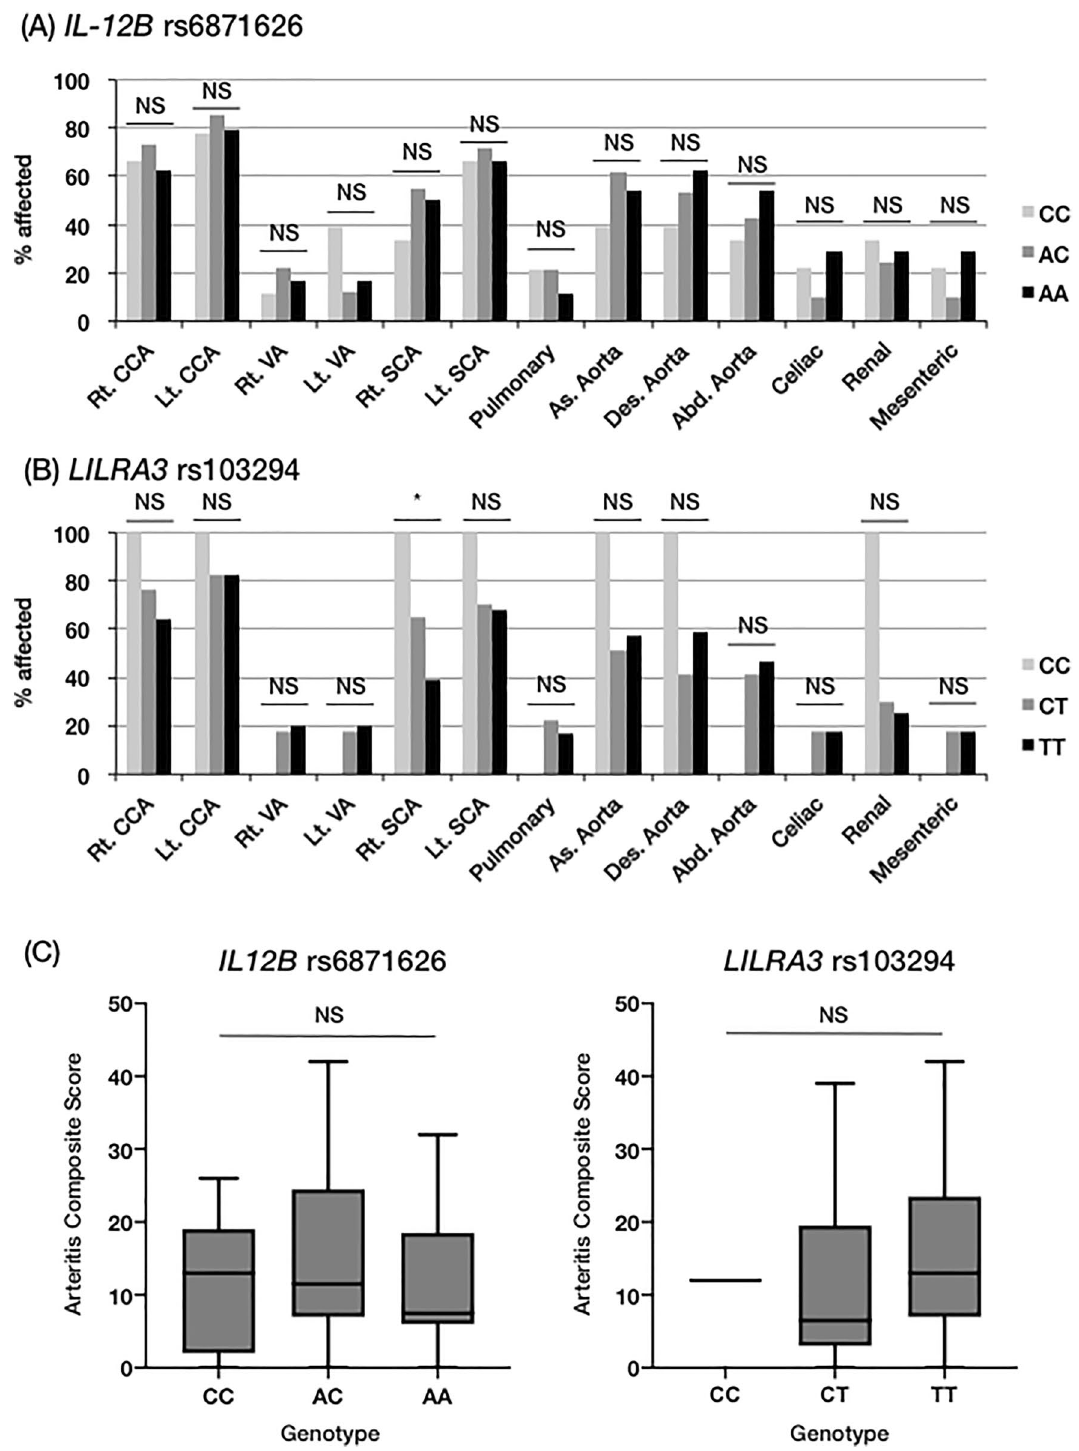
Figure 2. Association of genotypes with arterial involvement. ( A,B ) The association of IL12B rs6871626 and LILRA3 rs103294 with the distribution of arterial involvement. ( C ) The association of IL12B rs6871626 and LILRA3 rs103294 with Arteritis Composite Score. Rt right, Lt left, As ascending, Des thoracic descending, Abd abdominal descending, NS not significant. *P <